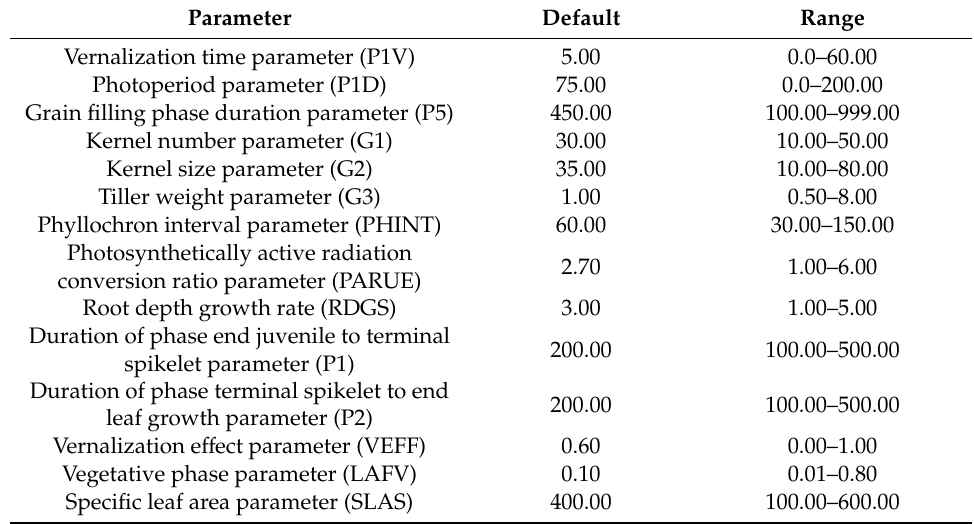
Table 1. Calibrated cultivar and ecological parameters for CERES (Crop Environment REsource Synthesis)-Wheat model